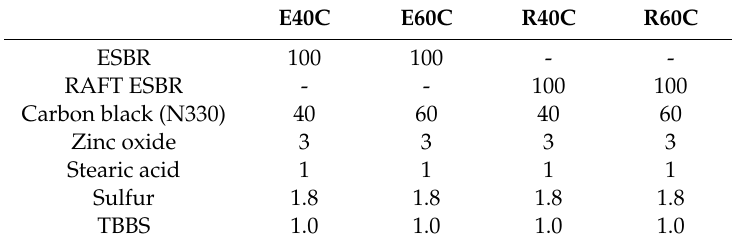
Table 2. Formulation of carbon black-filled compounds using emulsion styrene butadiene rubber (ESBR) and reversible addition-fragmentation radical transfer ESBR (RAFT ESBR); (Unit: phr).